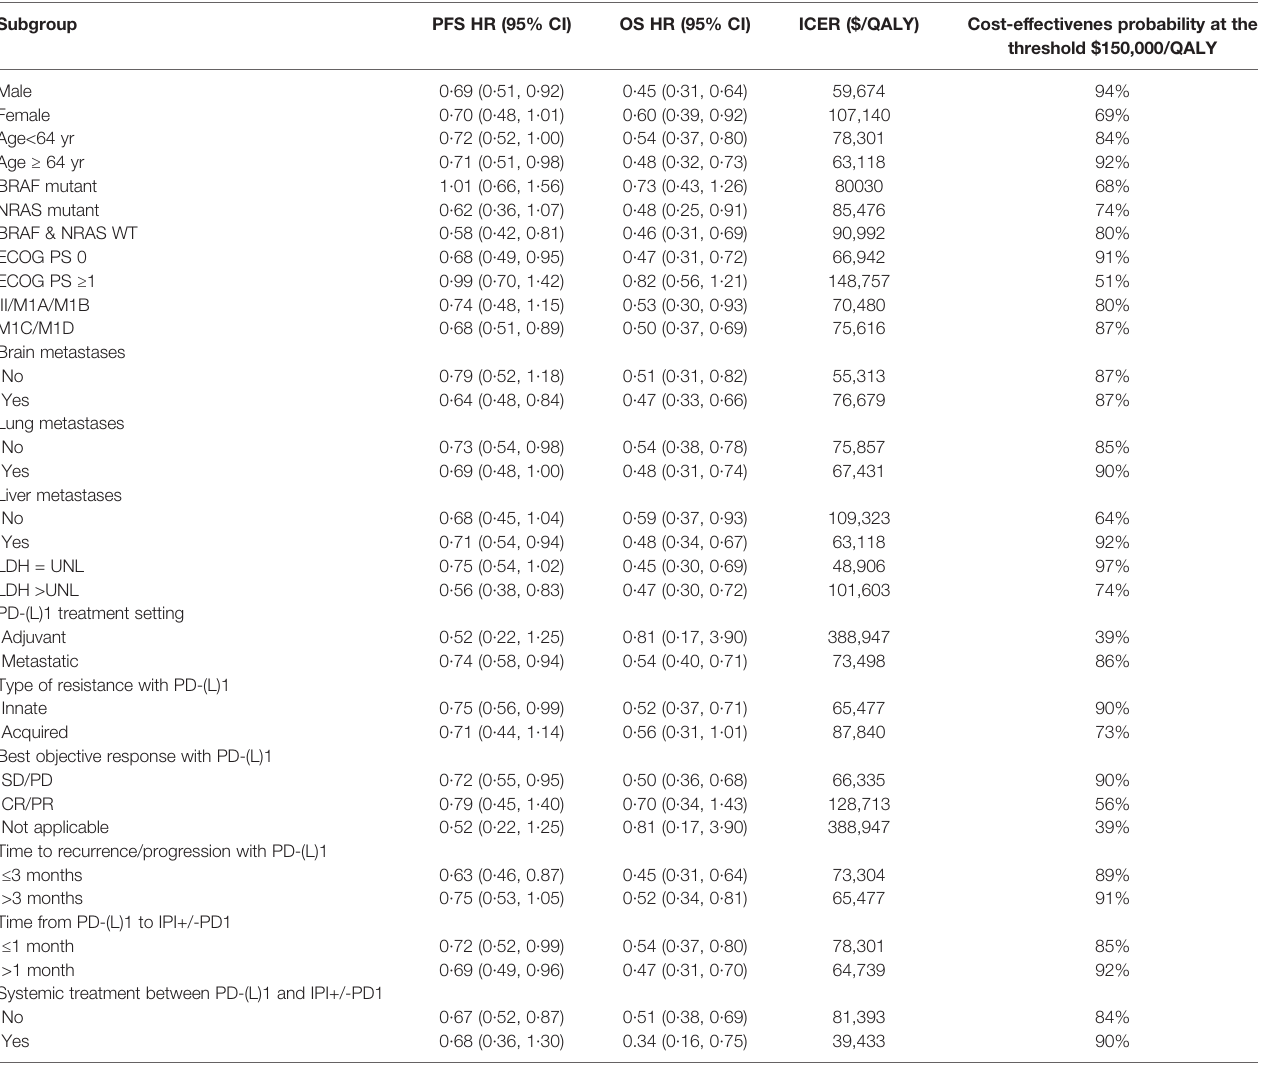
TABLE 3 | Results for subgroup